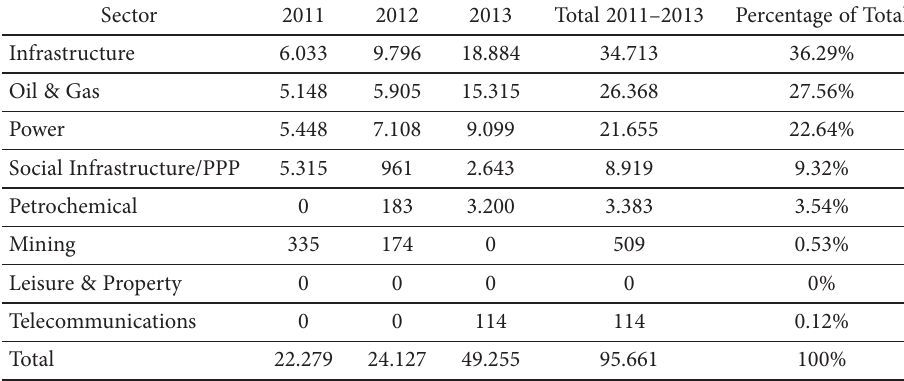
Source : Esty et al.